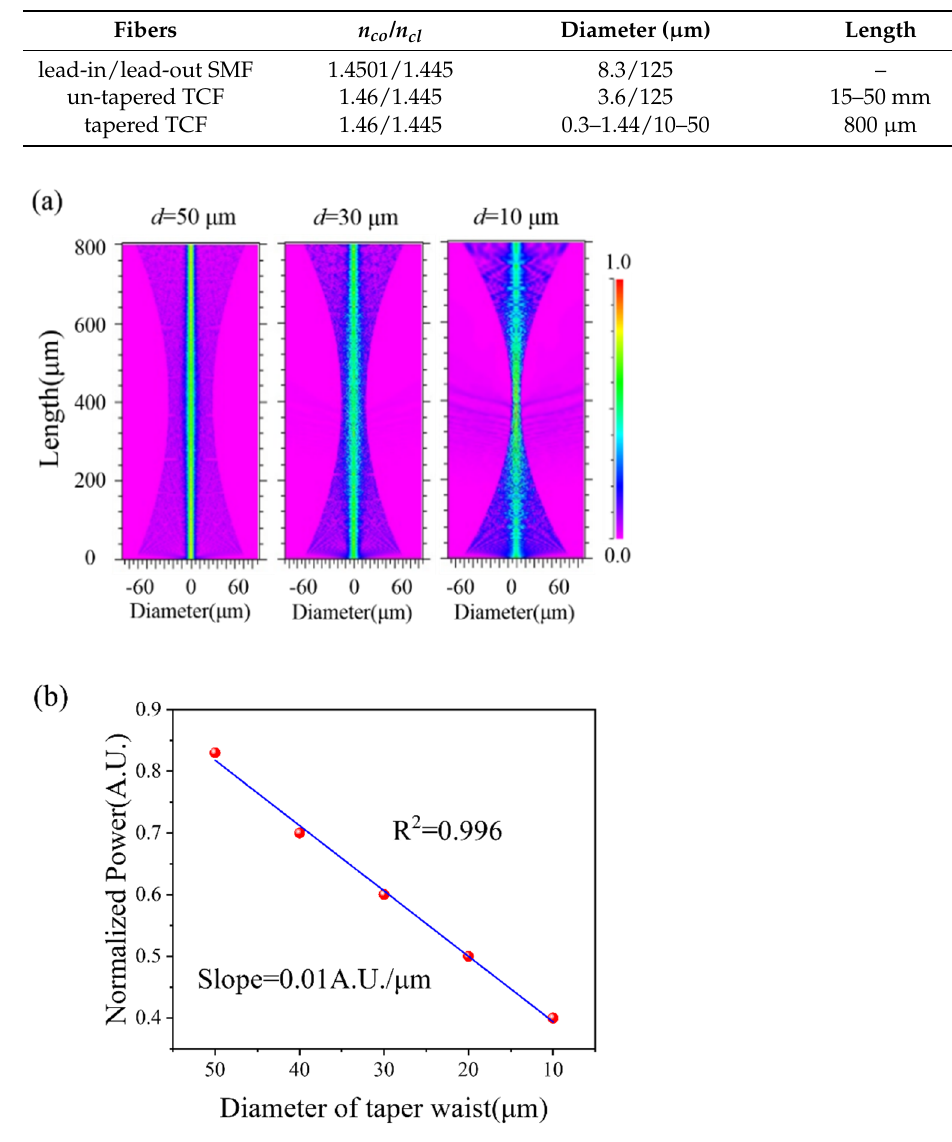
Table 1. The main parameters of the structure.